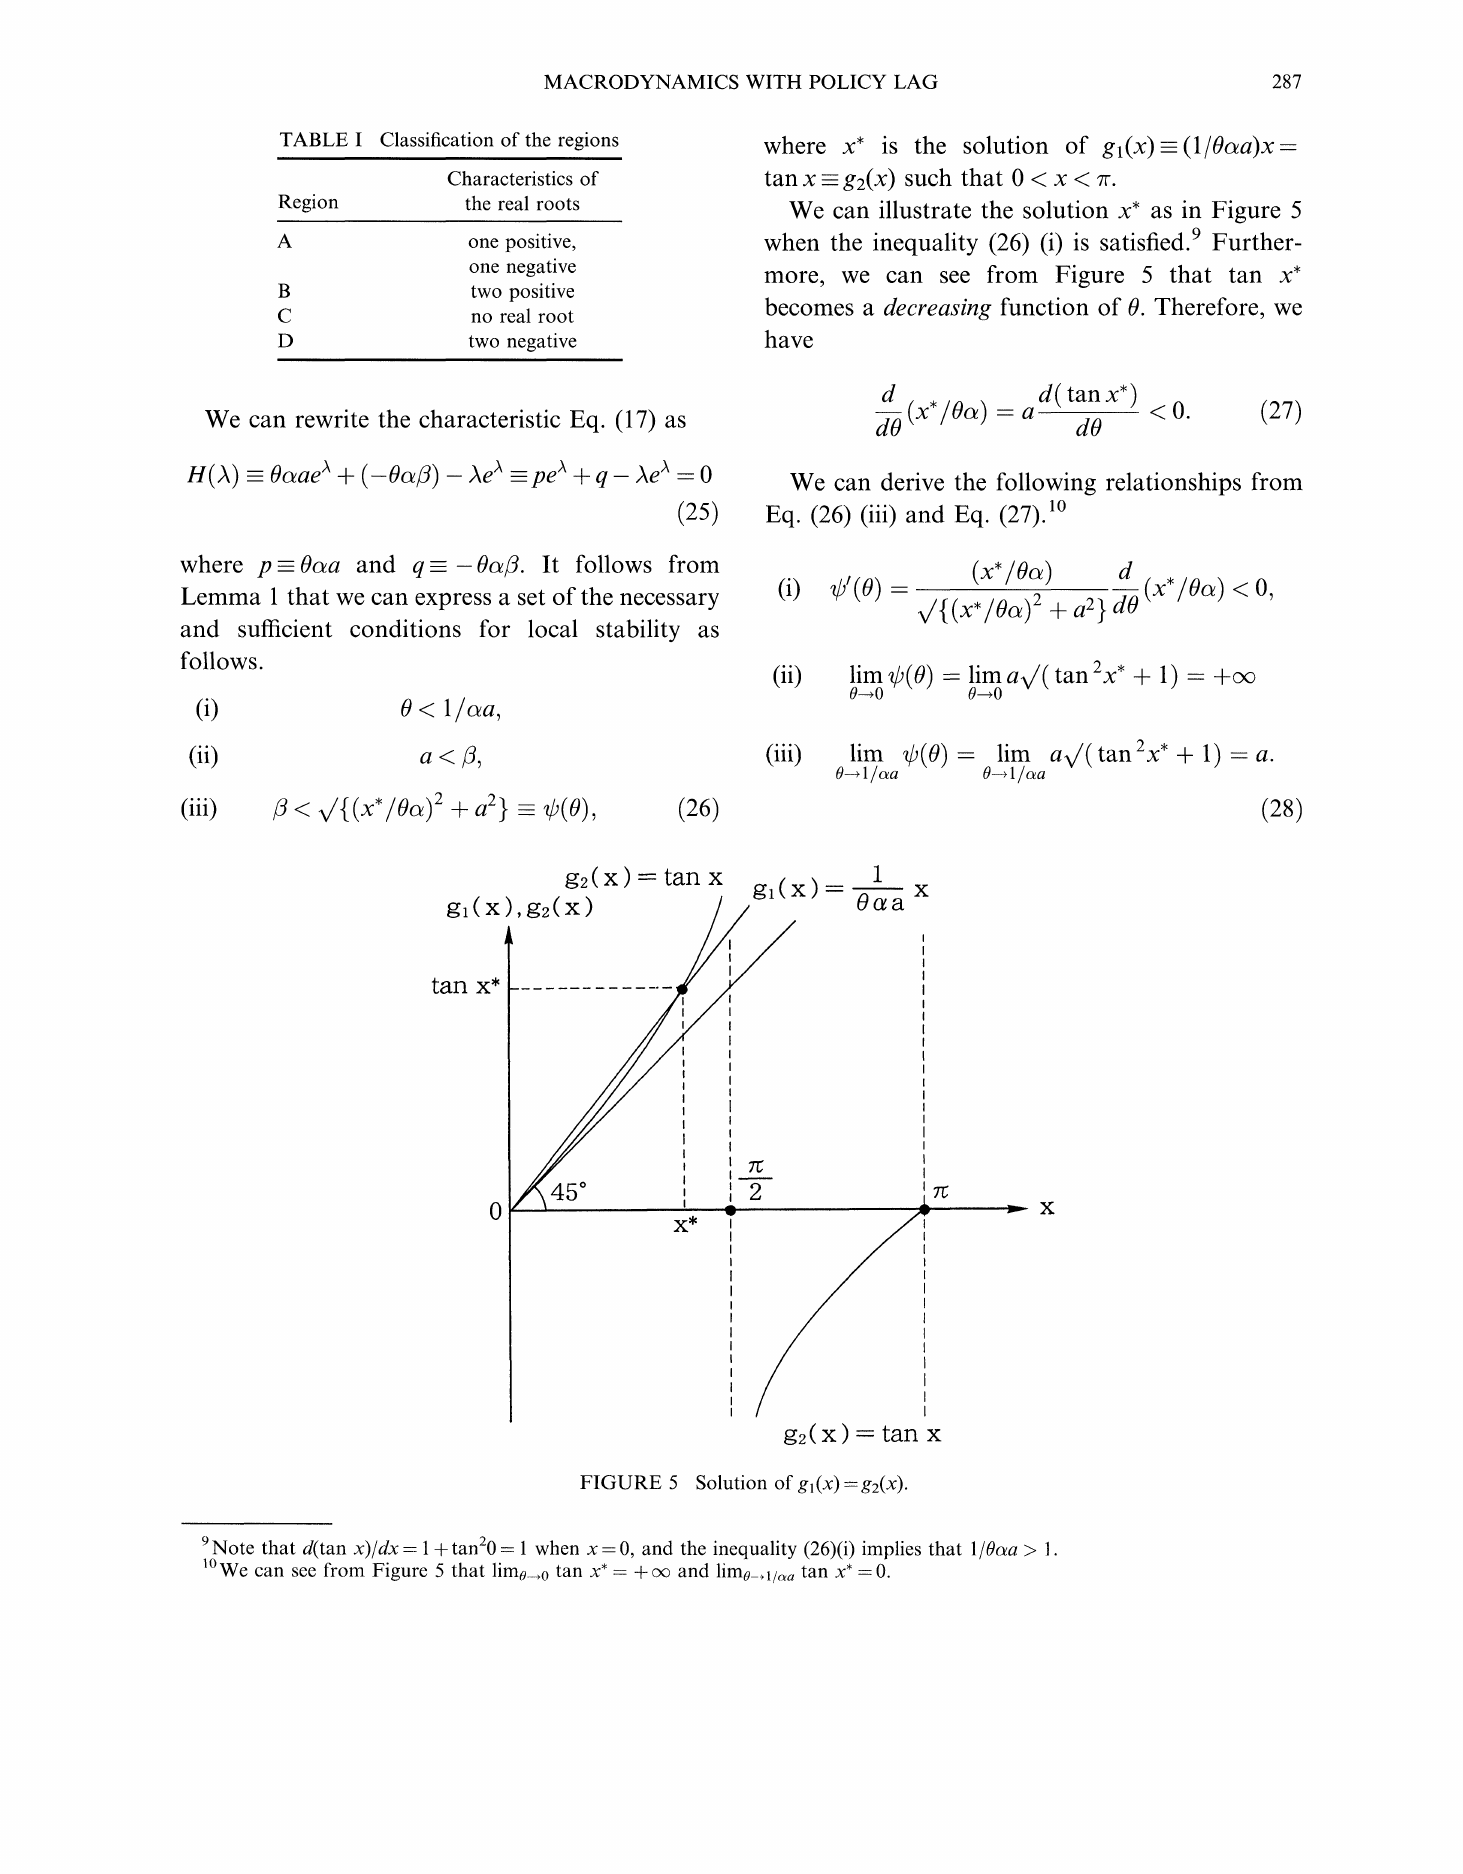
Classification of the regions Characteristics of Region the real roots